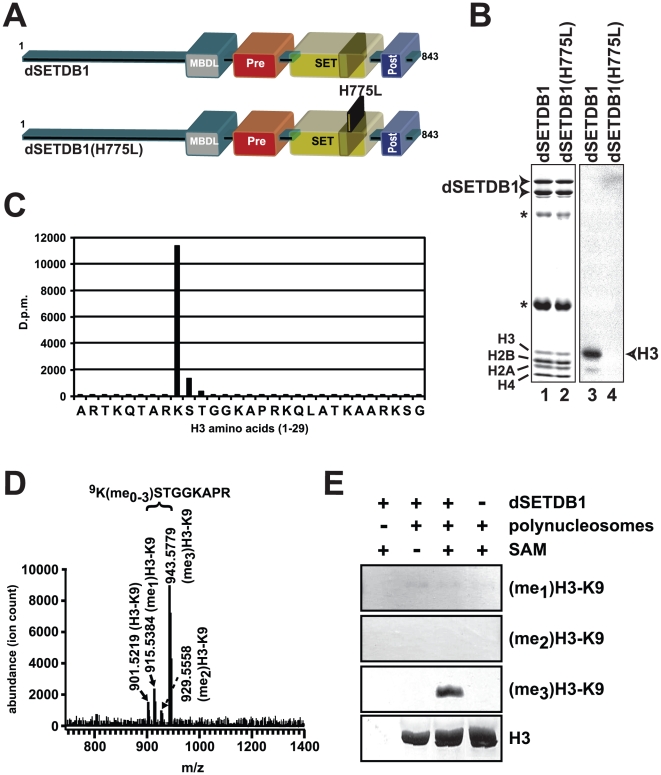
DSETDB1 preferentially tri-methylates lysine 9 in nucleosomal H3.(A) Schematic representation of dSETDB1 and dSETDB1(H775L), which contains a single amino acid exchange mutation of histidine (H) to leucine (L) at amino acid position 775. Rectangles mark the positions of the methyl cytosine binding (MBD)-like domain (MBDL), Pre-SET domain (Pre), SET-domain (SET), and Post-SET domain (Post). The dark box in the SET domain indicates the peptide insertion present in bifurcated SET domain of dSETDB1. (B) Coomassie-blue stained SDS-PAGE gel (left) and corresponding fluorogram (right) of histone methyltransferase (HMT) assays containing polynucleosomes, [3H]-S-adenosyl-methionine (SAM), and recombinant, immunopurified Flag-epitope–tagged dSETDB1 (lanes 1,3) or Flag-epitope–tagged dSETDB1(H775L) (lanes 2, 4). Asterisks mark the position of anti-Flag antibody light and heavy chain. (C) Microsequencing of radiolabeled nucleosomal H3. Polynucleosomes were incubated with recombinant dSETDB1 in the presence of [3H]-SAM. H3 was subjected to Edman degradation, and resulting amino acid fractions were analyzed by scintillation counting. The × axis shows amino acids 1–29 of H3. The y axis shows [3H]-labeling of amino acids in decays per minutes (D.p.m.). (D) Matrix-assisted laser desorption ionization–time-of-flight (MALDI-TOF) spectra of a high-performance liquid chromatography (HPLC) fraction containing the peptide 9K(me0–3)STGGKAPR of H3. Polynucleosomes were incubated with Flag-dSETDB1 and SAM. H3 was purified and proteolytically digested with trypsin. The resulting peptides were separated by HPLC. Fraction 4 containing 9K(me0–3)STGGKAPR was subjected to MALDI-TOF mass spectrometry. The × axis indicates the mass:charge ratio. The y axis indicates the abundance of peptides. The positions and m:z ratios of KSTGGKAPR peptides containing non-methylated lysine 9 in H3 (H3-K9), mono-methylated H3-K9 [(me1)H3-K9], di-methylated H3-K9 [(me2)H3-K9], and tri-methylated H3-K9 [(me3)H3-K9] are indicated. (E) Western blot analysis of HMT reactions programmed with recombinant Flag-dSETDB1, polynucleosomes, and SAM. Reaction products were separated by SDS-PAGE, electrophoretically transferred onto PVDF membrane, and probed with antibodies to (me1)H3-K9, (me2)H3-K9, (me3)H3-K9, and H3.